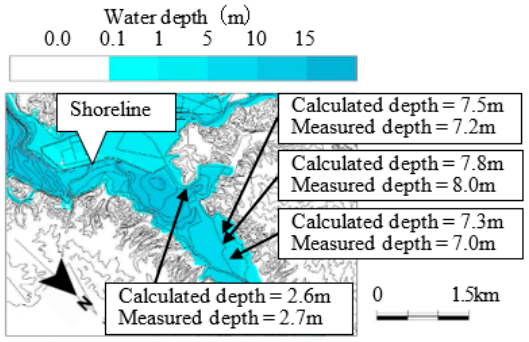
Figure 32. Flood situation in Kesennuma Coast 25 min after arrival of the 2011 huge tsunami.